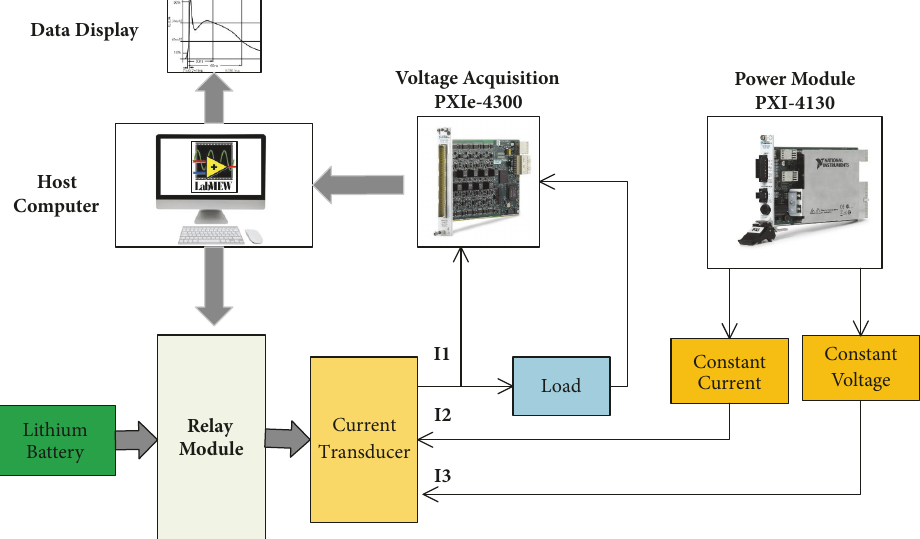
Figure 6: Lithium battery monitoring system based on LabView